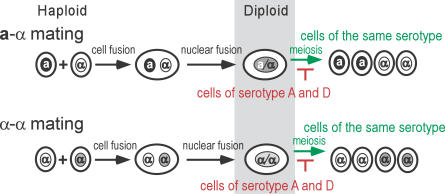

C. neoformans Mating CyclesDuring a–α mating (above), haploid a and α cells undergo cell–cell fusion to produce dikaryotic filaments, and nuclear fusion occurs late in the basidium to produce a transient diploid a/α state, which immediately undergoes meiosis and sporulation. Serotype-compatible parental strains produce viable haploid basidiospores of a and α mating type [43,44]. During same-sex mating (below), haploid cells of one mating type (mostly α) become diploid cells (α/α), which can undergo meiosis and sporulation (lower panel) [40,48]. In either mating cycle, if the parental strains are of different serotypes, hybrids are trapped in the diploid state because of an impaired ability to undergo meiosis as a consequence of DNA divergence (5%–10% nucleotide polymorphisms between serotype A and D). Outer circles represent cells and inner circles represent nuclei; a or α indicate mating type. Green indicates efficient meiosis, and red indicates impaired meiosis.